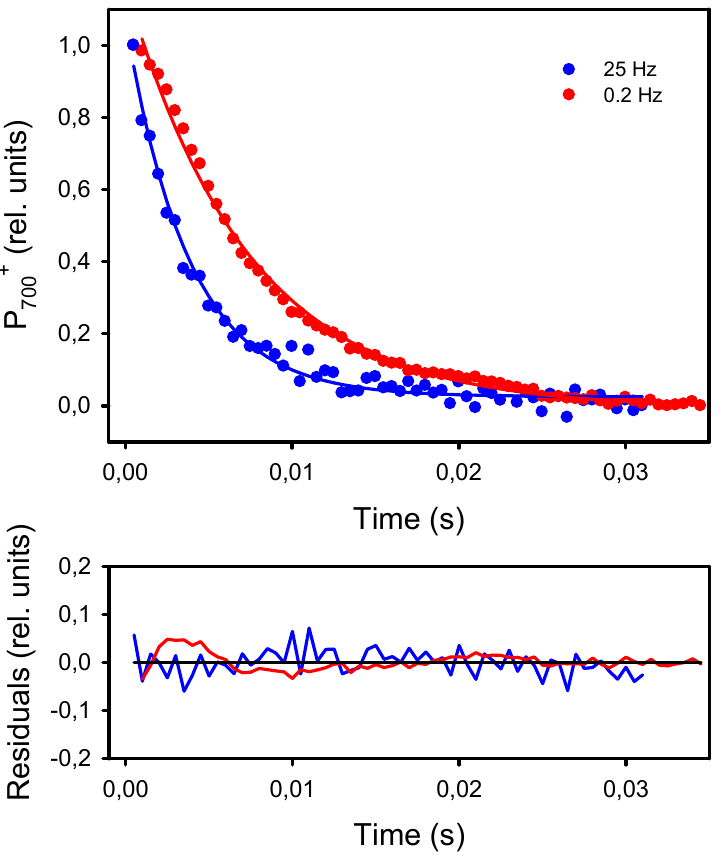
Figure 7. Kinetics of P 700+ dark-reduction observed at the end of the light pulses given at 25 Hz and 0.2 Hz. The kinetics were fitted to the equation f = y 0 + a * exp −k*t , where “k” is the reduction rate. The solid lines represent the curves calculated from the regressions. The residuals of the regressions are shown in the lower graph.